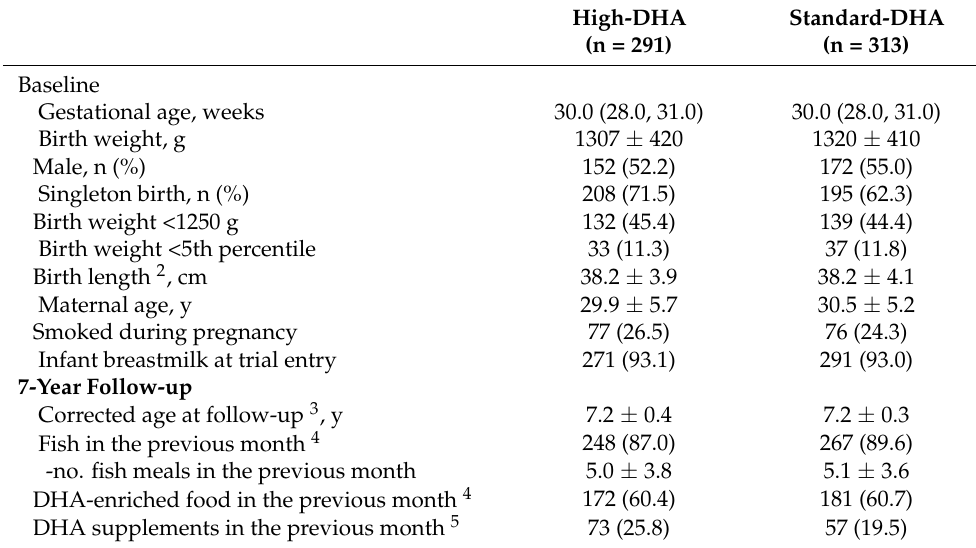
Table 1. Baseline and 7-years follow-up participant characteristics by treatment group 1 .